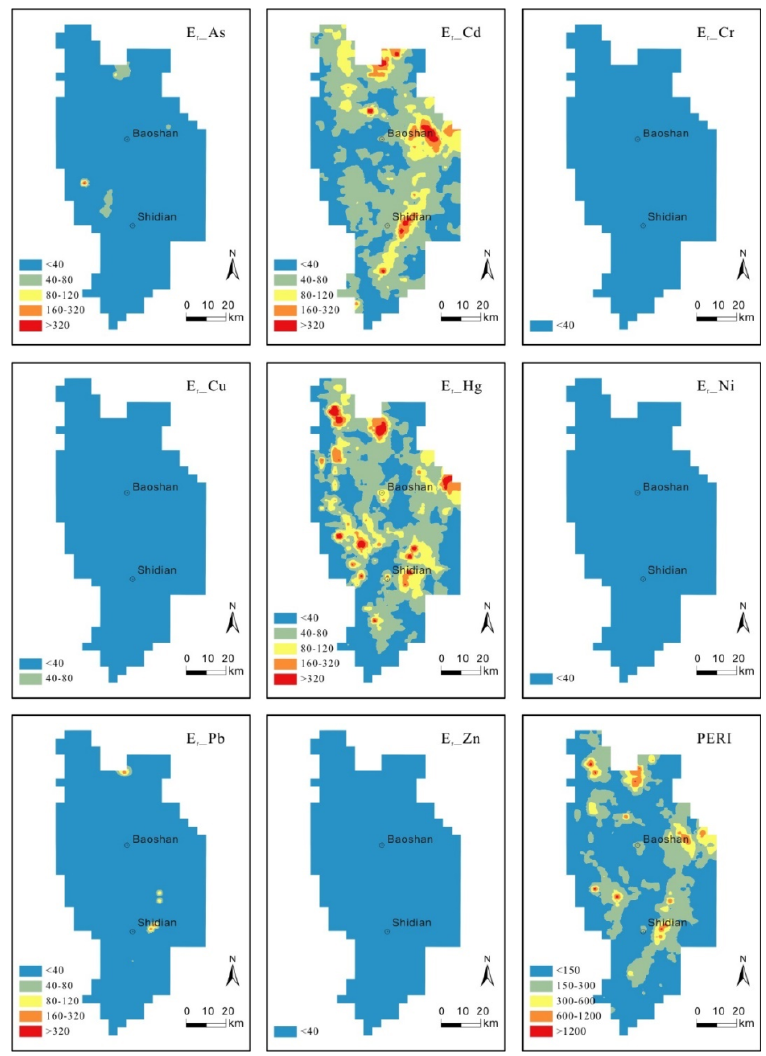
Figure 6. The distribution of counter maps of the potential ecological risk ( E i r ) of a particular PTE and potential ecological risk index (PERI) of all of the studied PTEs determined by inverse distance weighted (IDW)